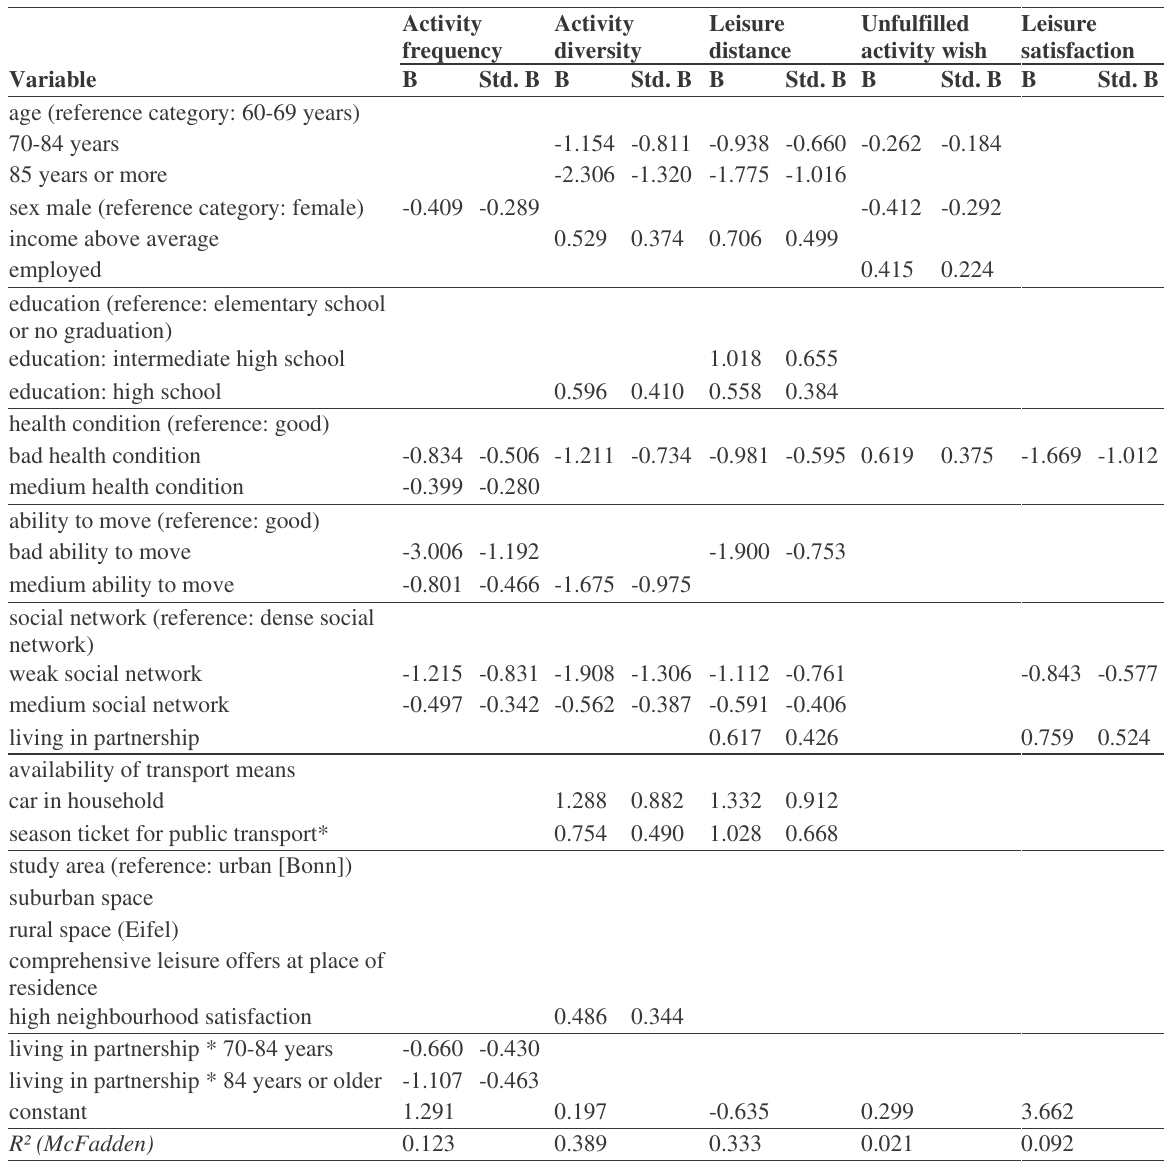
Table 3. Determinants of leisure mobility of elderly people: results of five logistic